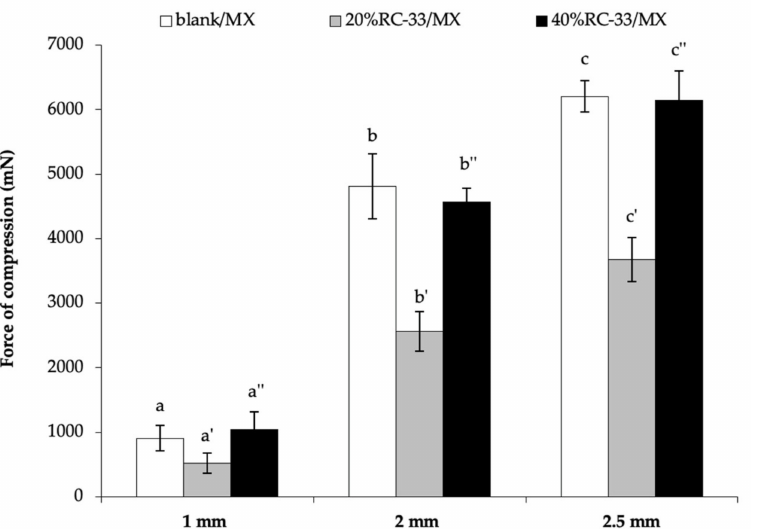
Figure 7. Compression force values of freeze-dried matrices loaded with RC-33 amounts correspond- ing to 20% and 40% of the GG interaction sites (respectively, 20% RC-33-loaded freeze-dried matrix (RC-33/MX) and 40% RC-33/MX); blank/freeze-dried matrix (MX) was used as reference (mean values ± s.e.; n = 3). One-way ANOVA; post hoc Scheff é test ( p ≤ 0.05): b vs. b’; b’ vs. b”; c vs. c’; c’ vs.